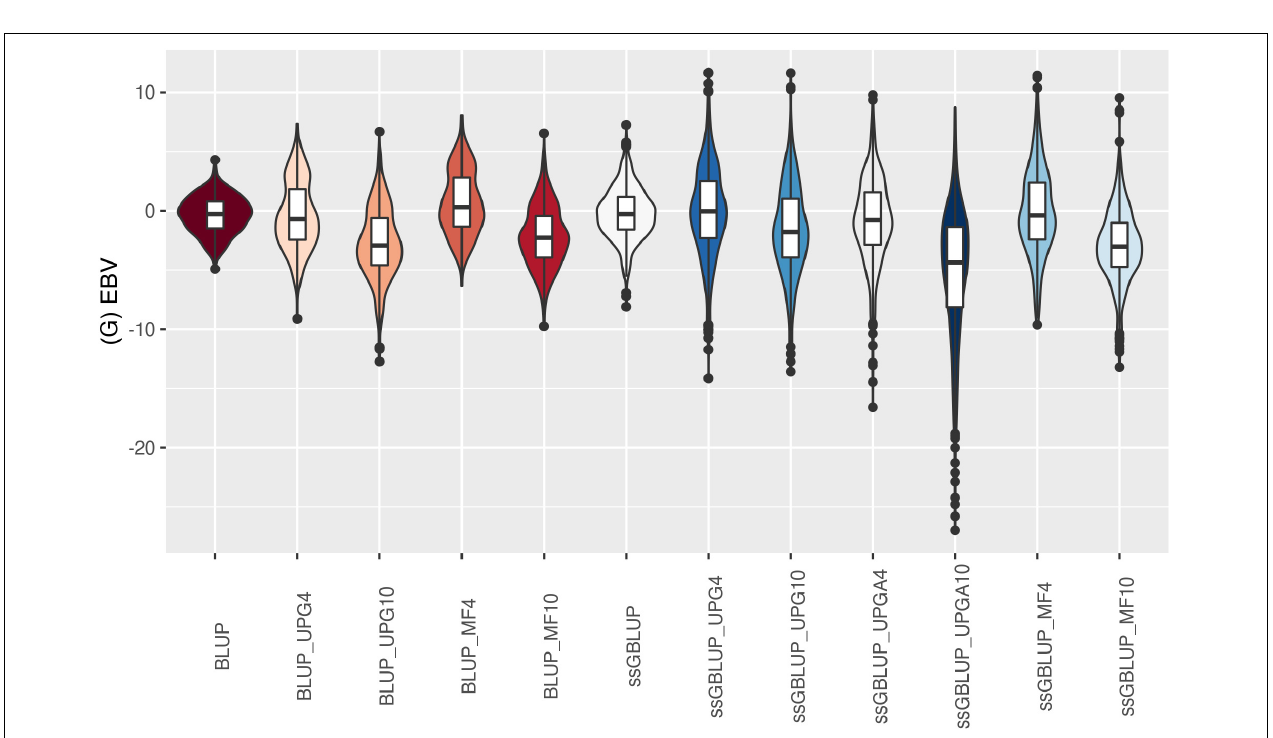
FIGURE 9 | (G)EBVs for validation animals for weaning weight direct estimated using various models with and without genetic groups. (G)EBVs, (genomic) estimated breeding values.